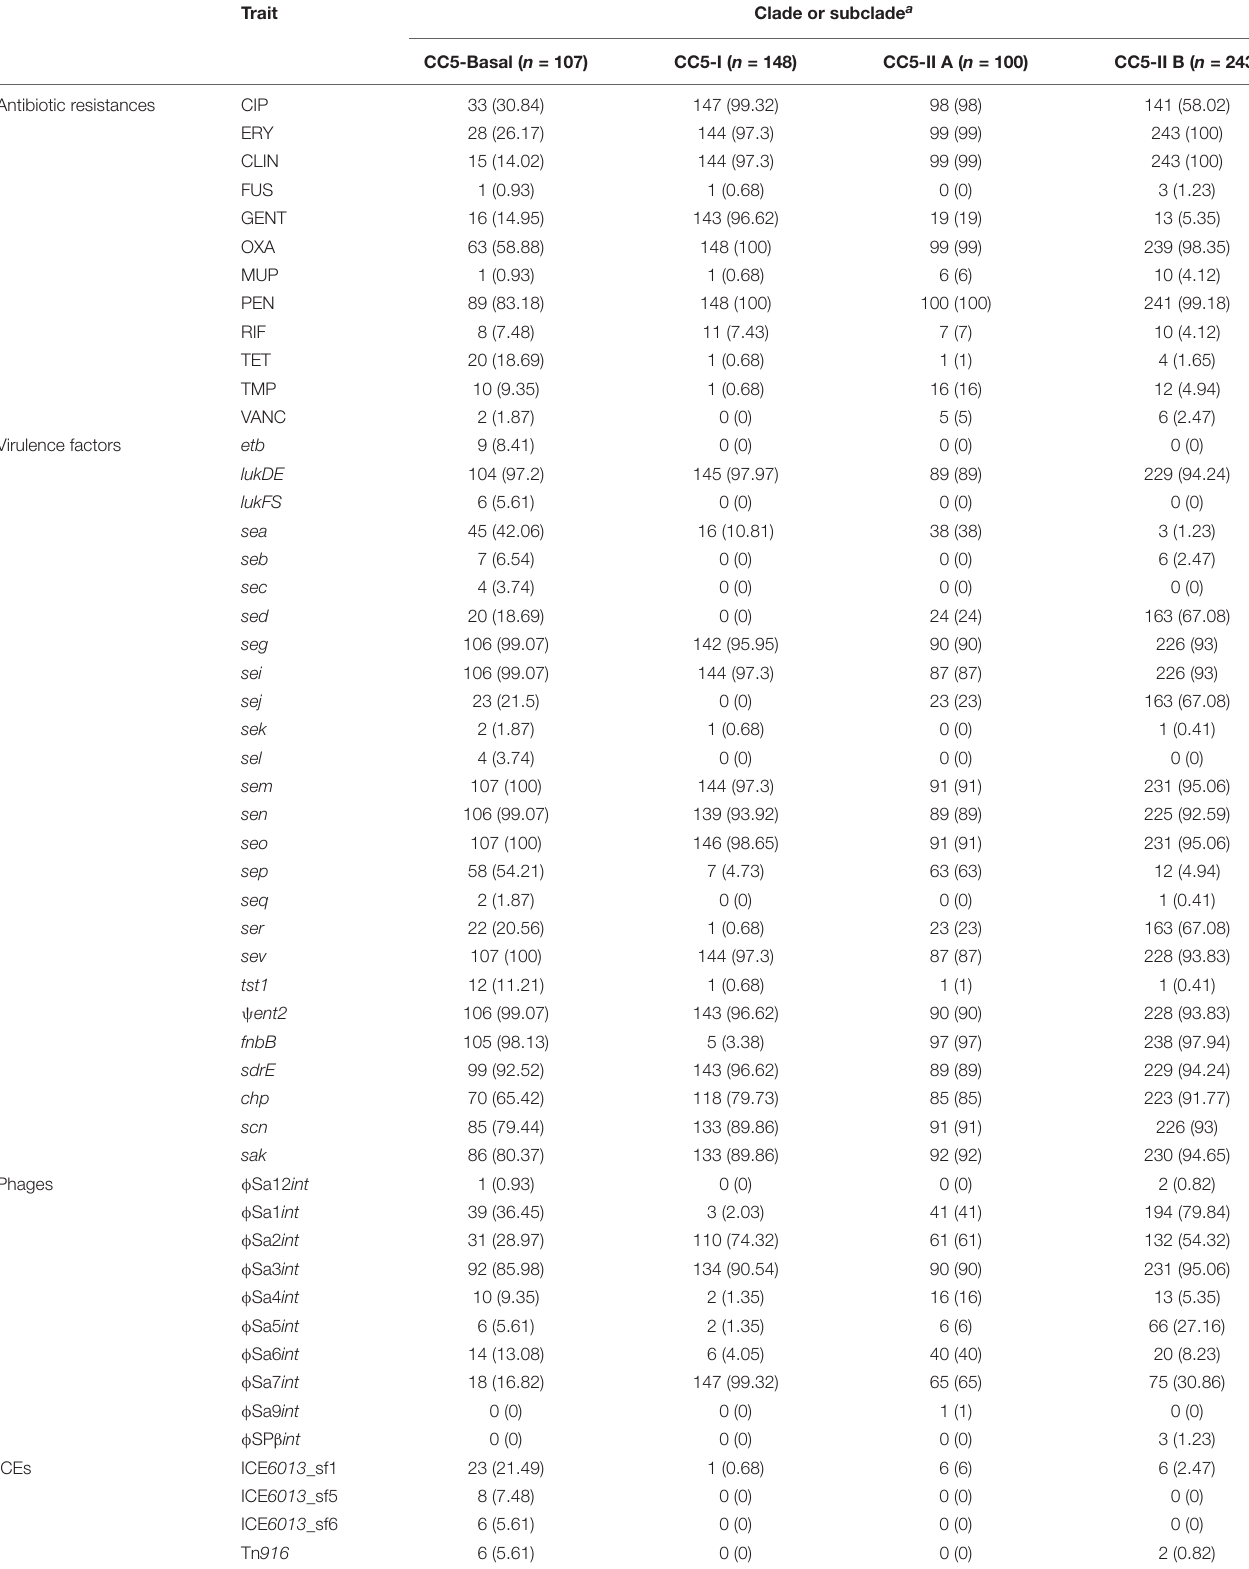
TABLE 2 | Prevalence of selected traits in CC5